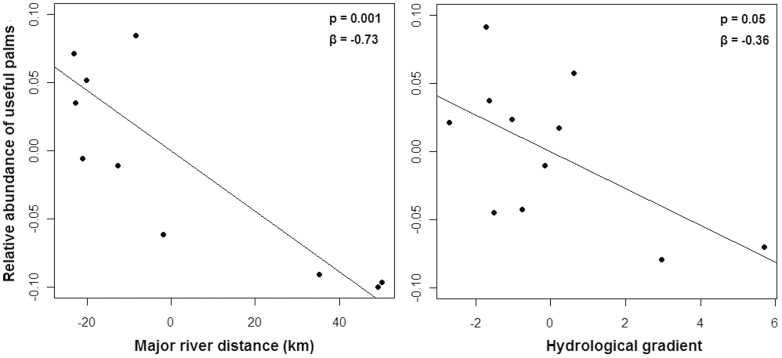
Multiple regression analysis of useful palms and the distance from rivers and the hydrologic gradient.Partial regressions between the relative abundance of useful palms and the distance of each plot to the major rivers (left) and the hydrologic gradient (right). The full multiple regression model has an R2 = 0.73. Points are the plots of all sites, totaling 11 plots.